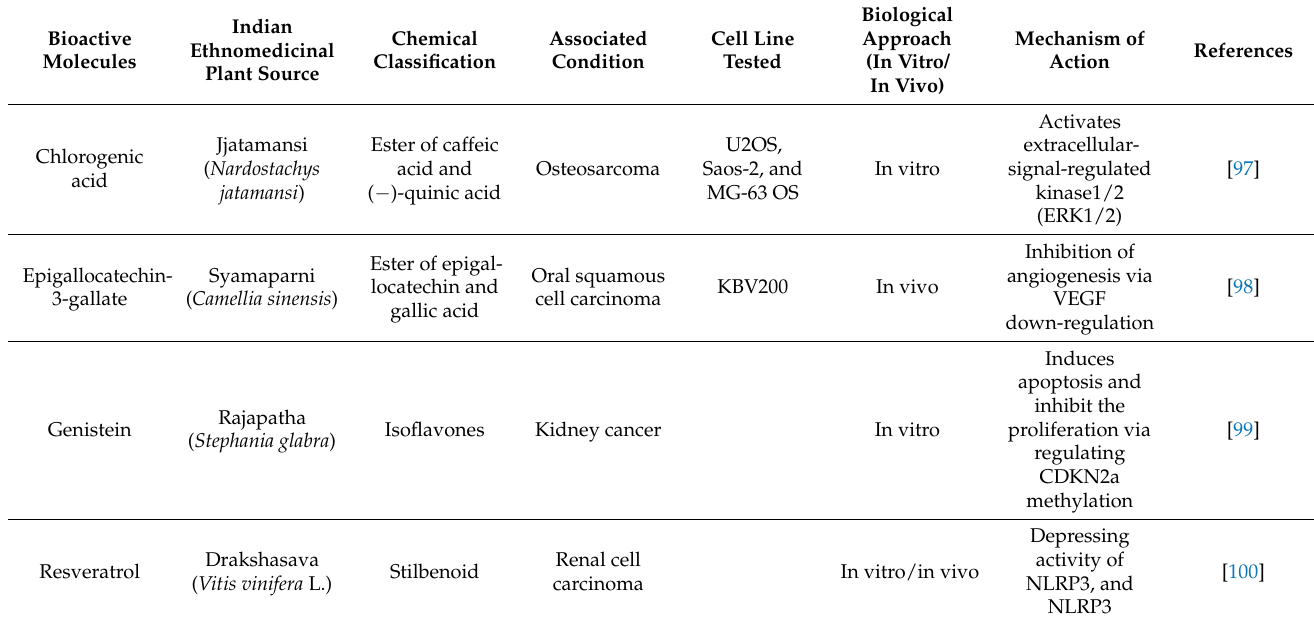
Table 3. Anti-cancer activity of some potent antioxidant phenolic phytochemicals (recent data). Bioactive